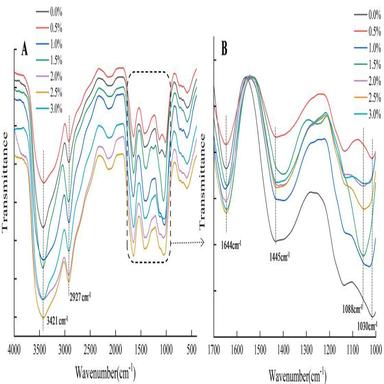
FTIR spectra of the PPI/PUL NFs cross-linked by glucose.